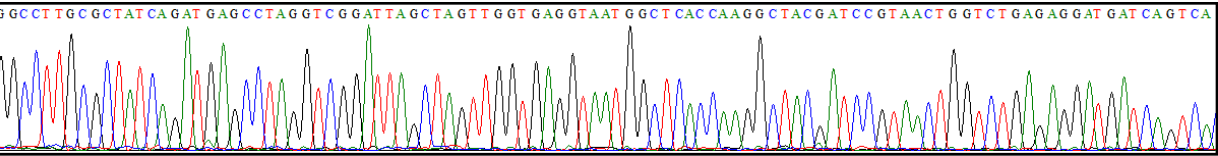
Figure 2. Chromatogram of a DNA sequence corresponding to the 16S rRNA gene fragment of a Pseudomonas putida (T16) found in Leporinus piau from Tapajós.